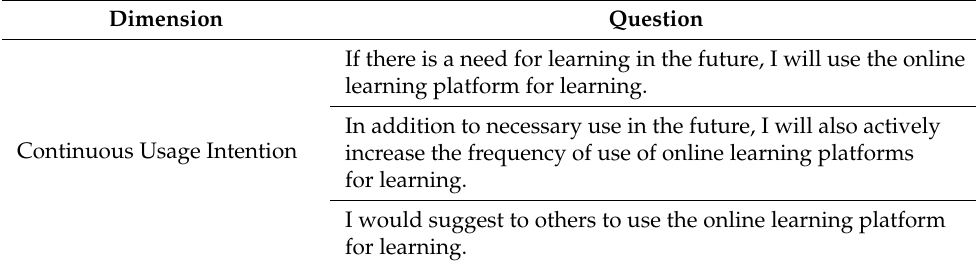
Table 4. Questionnaire items referenced from Liao and Lu